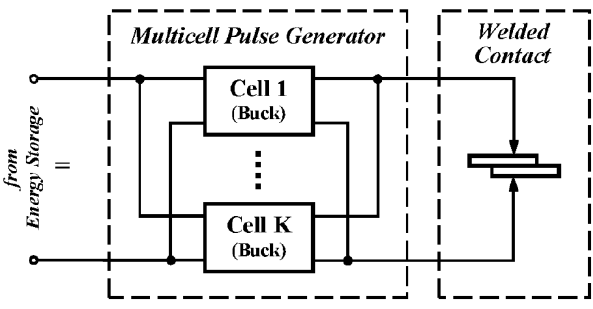
Fig. 7. The circuit of the output generator of welding